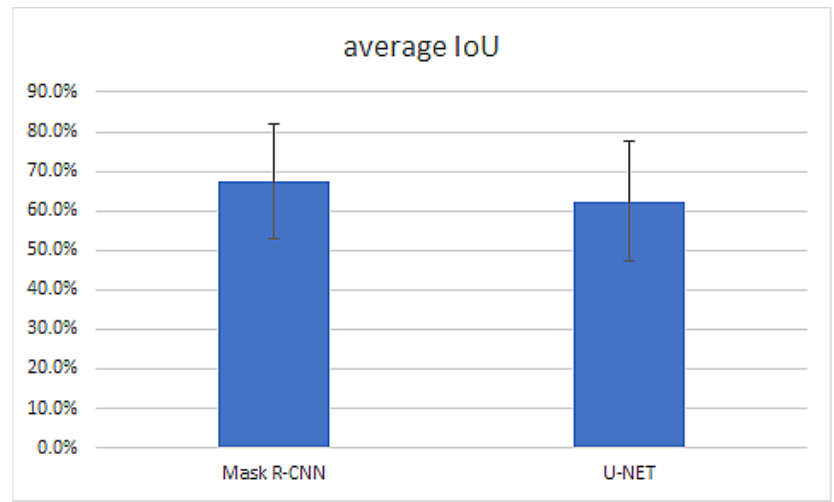
Figure 12. Weighted average IoU for Mask R-CNN and U-NET.